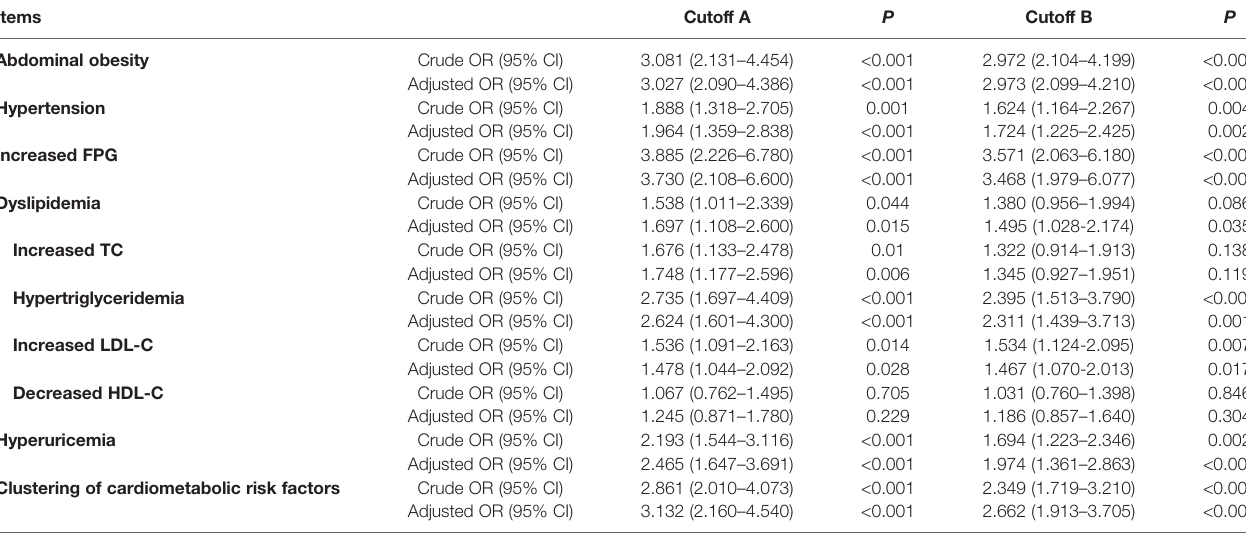
TABLE 2 | The in fl uence of insulin resistance on cardiometabolic risk factors according to different de fi nitions of insulin resistance.